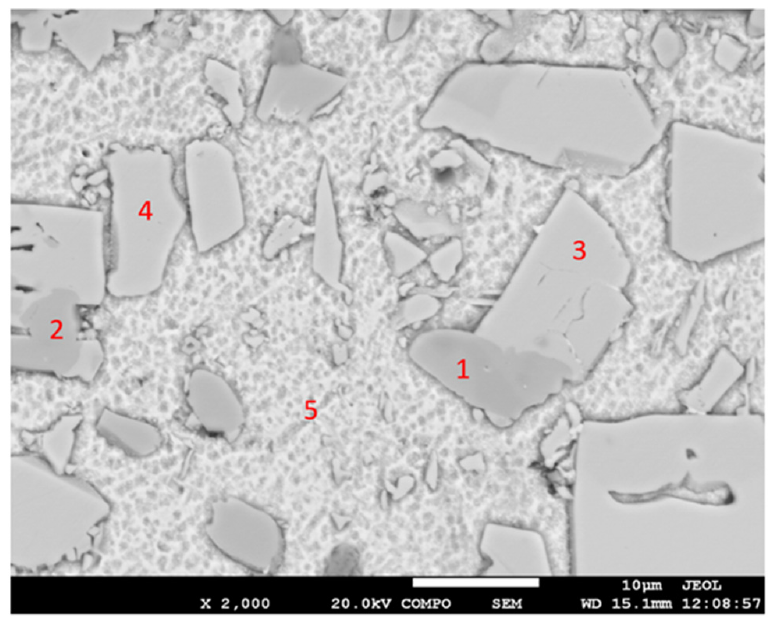
Figure 17 . Representation of measuring points of the SiC/Sn5Sb3Ti/Cu–SiC joint . Figure 17. Representation of measuring points of the SiC/Sn5Sb3Ti/Cu–SiC joint. Table 6. Point EDX analysis of the SiC/SnSb5Ti3/Cu–SiC joint. Spectrum Sn (wt.%) Sb (wt.%) Ti (wt.%) Solder Component Spectrum 1